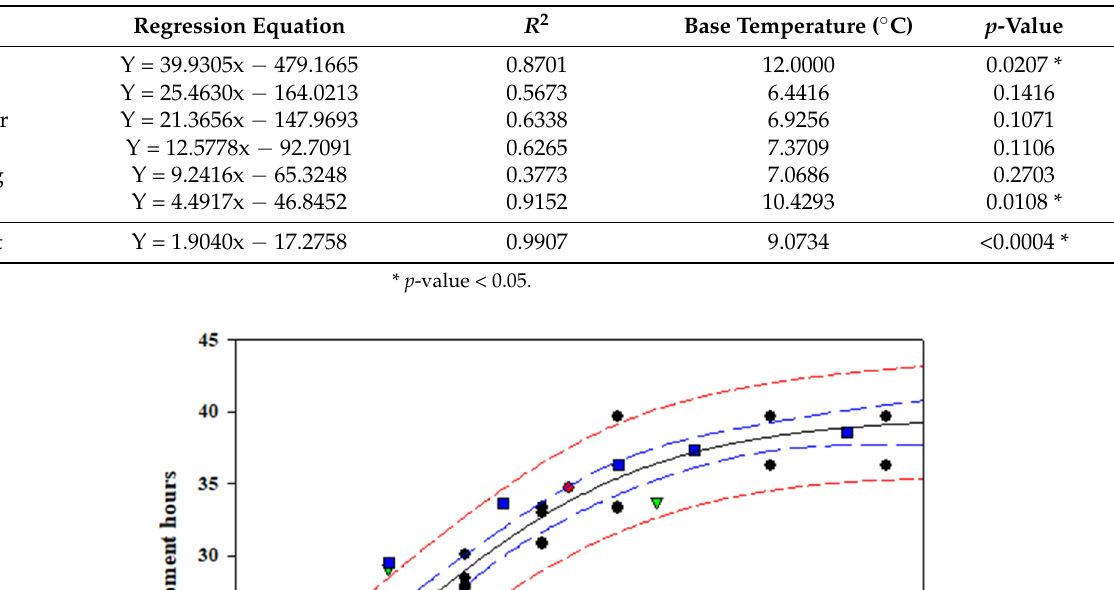
Figure 2. Boxplot of body length according to developmental stages in L . sericata ( n = sample size) . Table 1. Base temperatures and p values for Lucilia sericata according to development stage. Body length was greatest at the feeding third instar stage but decreased during pupation.